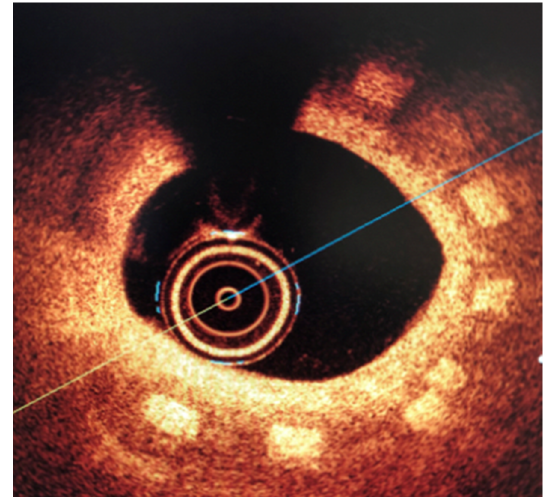
Figure 14. Optical coherence tomography at 28 days follow-up show optimal vascular response and stent geometry. Stent struts show blurred image, a sign of early hydrolysis (rectangle).